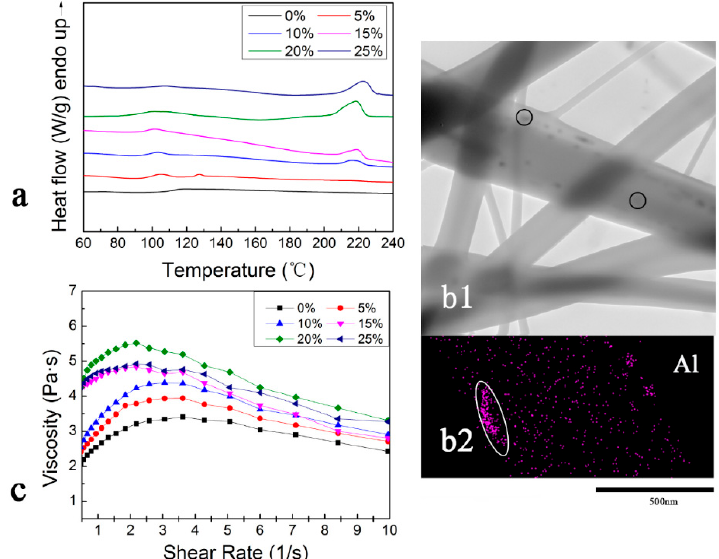
Figure 3. Analysis of the fabrication of sc -PLA in PMMA. ( a ) DSC melting curves for the different samples with various sc -PLA contents. ( b1 ) TEM images for sc -PLA/PMMA nanofibers with 20 wt % sc -PLA contents. ( b2 ) EDS mapping of aluminum. ( c ) Change of viscosity with shear rate for various sc -PLA contents.